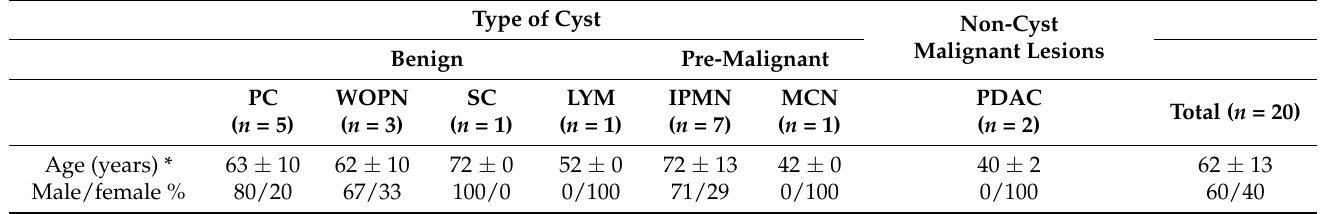
Table 1. Patient Description.